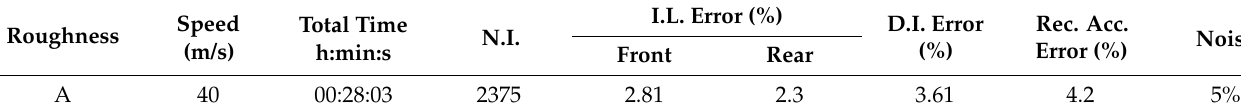
Figure 9. Two-span continuous bridge.